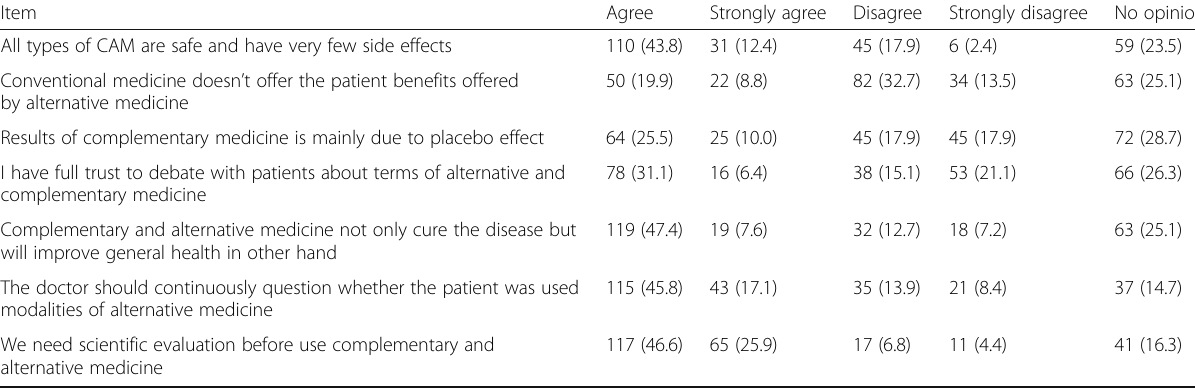
Table 8 Participant ’ s beliefs about complementary and alternative medicine